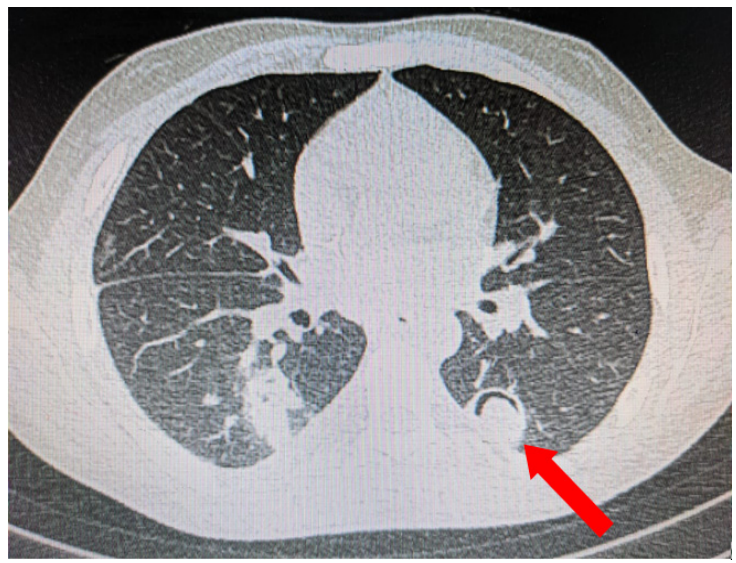
Figure 4. Pleural-based consolidation with cavity and a radio-opaque shadow within the cavity leading to formation of ‘air crescent’ (red arrow).